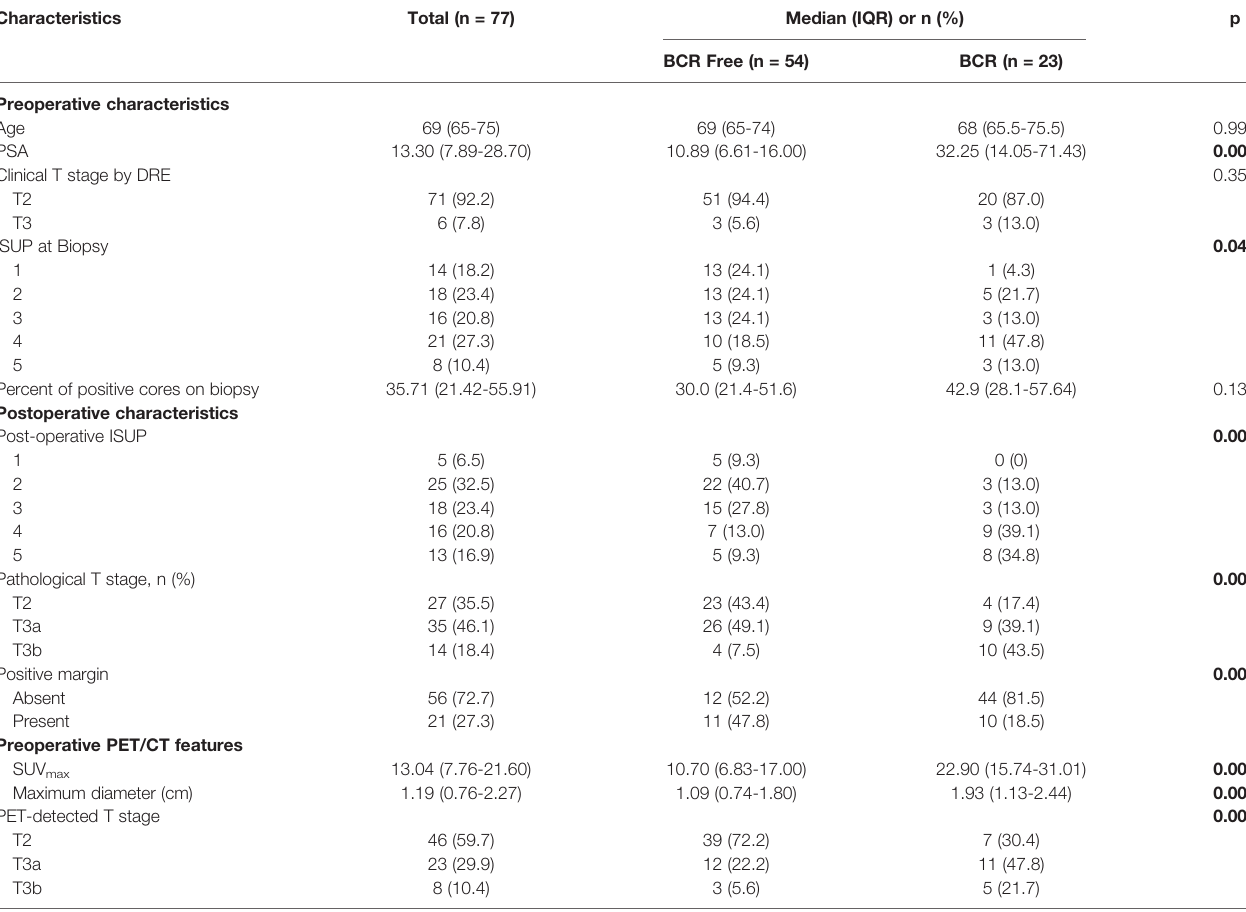
TABLE 1 | Characteristics of prostate cancer patients with 68 Ga-PSMA PET/CT scanning prior to radical prostatectomy.